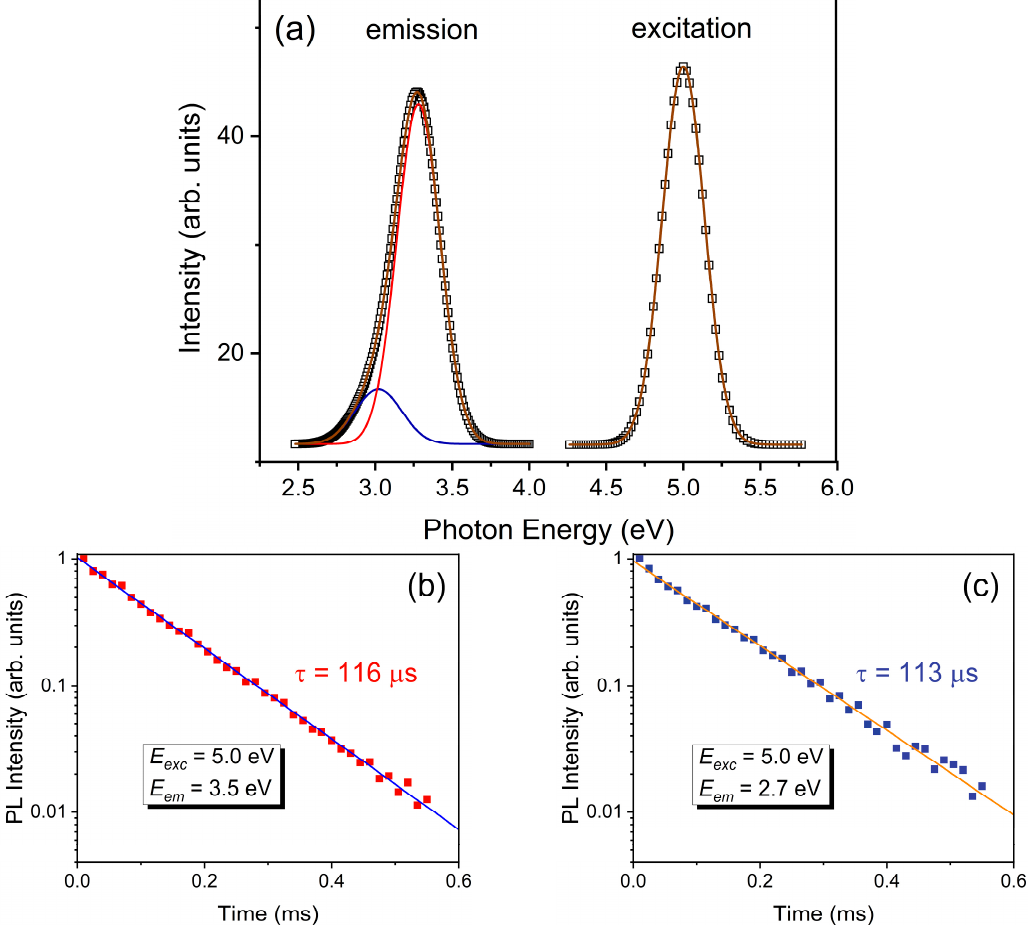
Figure 6. Room-temperature emission and excitation spectra of Y 2 O 3 film. Red and blue lines show emission bands associated with radiative recombination of bound exciton and self-trapped exciton, respectively ( a ). Emission decay curves were measured at E em = 3.5 eV, E exc = 5.0 eV ( b ) and E em = 2.7 eV, E exc = 5.0 eV ( c ). The accuracy of the emission lifetime was ±3 μ s. For cubic Y 2 O 3 in different morphologies (bulk crystal, transparent ceramic, nanopar- ticles), the luminescence at 3.4–3.5 eV is related to the radiative de-excitation of self- trapped excitons ( STE ) [9,11,12,41,42]. We believe that the dominant emission band lo- cated at 3.3 eV is also associated with the STE radiative recombination in Y 2 O 3 film, and the spectral position of this band is shifted to the low-energy region when compared to bulk and low-dimensional cases. As for the second emission band, it is located at 3.0 eV, and the low-intensity luminescent band observed in the cubic Y 2 O 3 is associated with the radiative recombination of the bounded exciton ( BE ), which was localized in the anion vacancy center of the F -type [11,42]. Thus, we believe that emission bands located at 3.3 eV and 3.0 eV are associated with STE and BE , respectively. Figure 6b,c show the decay curves of exciton emission. The measurements were car- ried out by monitoring the emission wavelengths at the tails of the bands in order to avoid their overlap. The decay curves of both emission bands are single-exponential, and the emission lifetimes are 116 μ s (E em = 3.5 eV) and 113 μ s (E em = 2.7 eV). A large Stokes shift